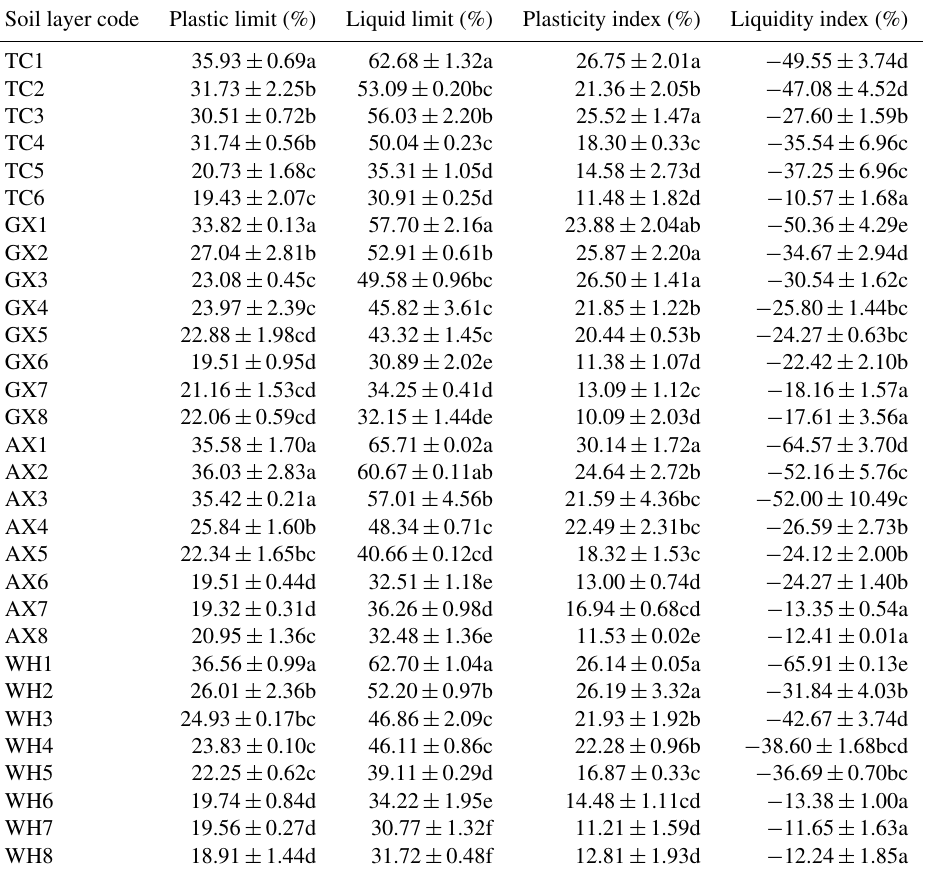
Table 4. Soil Atterberg limits of different weathering profiles of the four collapsing gullies. Soil layer